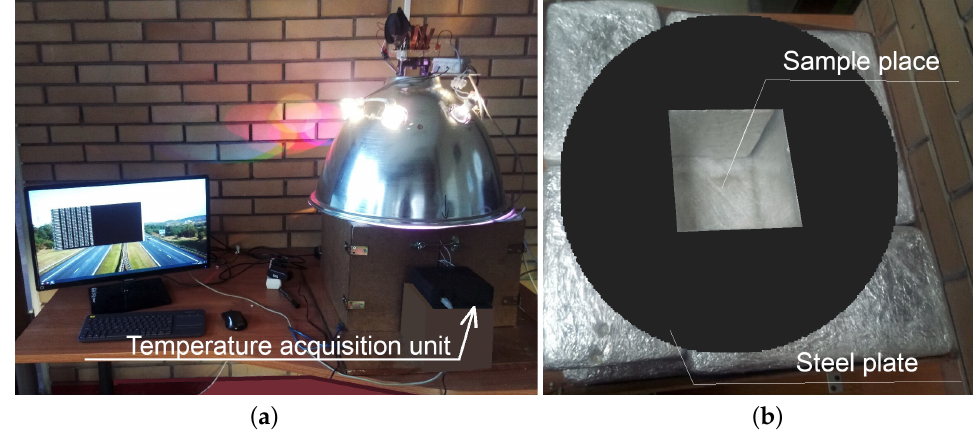
Figure 4. The test bench: ( a ) overall view, ( b ) part with the thermal insulation and the steel plate. A set of five thermoelectric transducers (type K thermocouples) was connected to a temperature acquisition unit presented in Figures 4a and 5a and used to record the temperature changes at the height of the heated sample. The design of the acquisition unit has been based on a microcontroller embedded in the MEGA2560 R3 integrated circuit with ATMega2560 16 MHz microcontroller and CH340 programmer. A set of five thermoelectric transducers MAX6675 with SPI interface is used to process the signals. In the Figure 5b the direction of heat flow during the sample heating is shown with a yellow arrow and the specific transducers are marked from T1 to T5 with red color. The transducers are arranged vertically, i.e., thermocouple no. 1 (mark T1) is on the top of the sample (closest to the heated surface—1.5 cm) and thermocouple no. 5 (mark T5) is on the bottom of the sample (farthest from the heated surface—13.5 cm). The transducers were placed in holes drilled in the sample and guarantee the location of transducer’s measuring element in its axis.